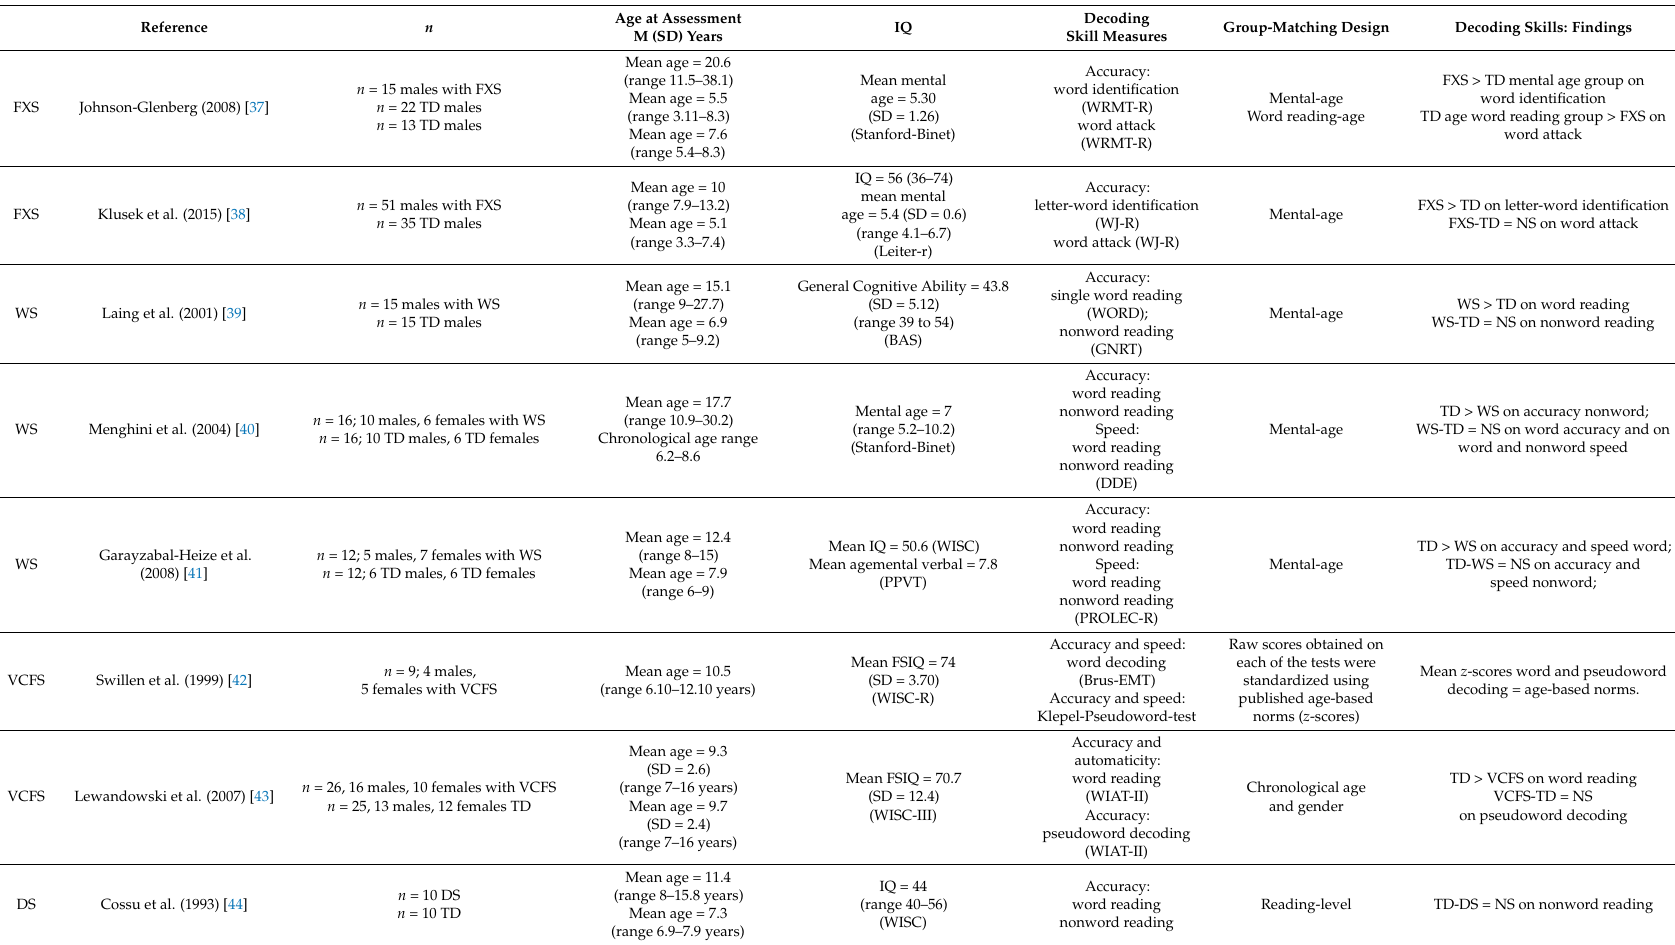
Table 1. List of selected studies. FXS = Fragile X Syndrome. WS = Williams Syndrome. VCFS = Velocardiofacial Syndrome. DS = Down